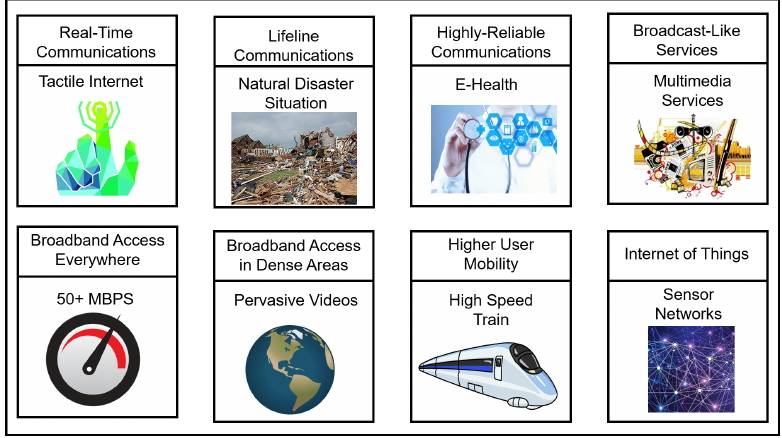
Figure 5. 5G use cases and related examples. Adapted from: